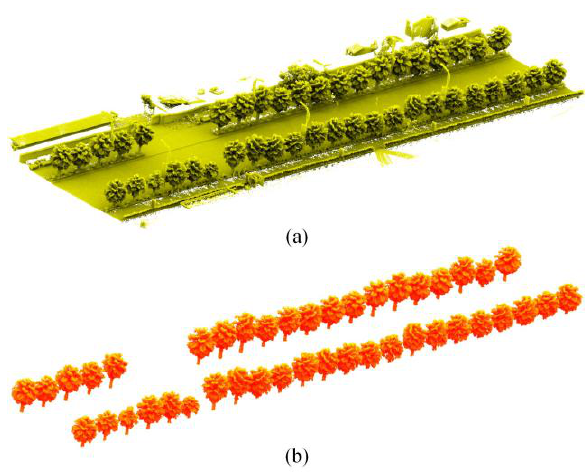
Figure 7. (a) Dataset III, and (b) extracted 3D